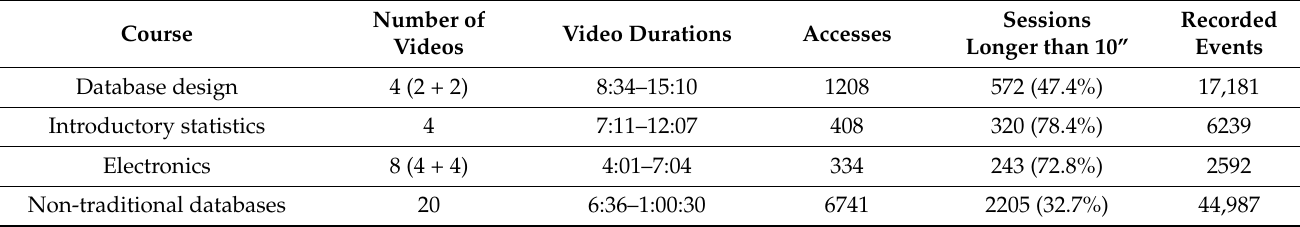
Table 1. Summary of the analysed